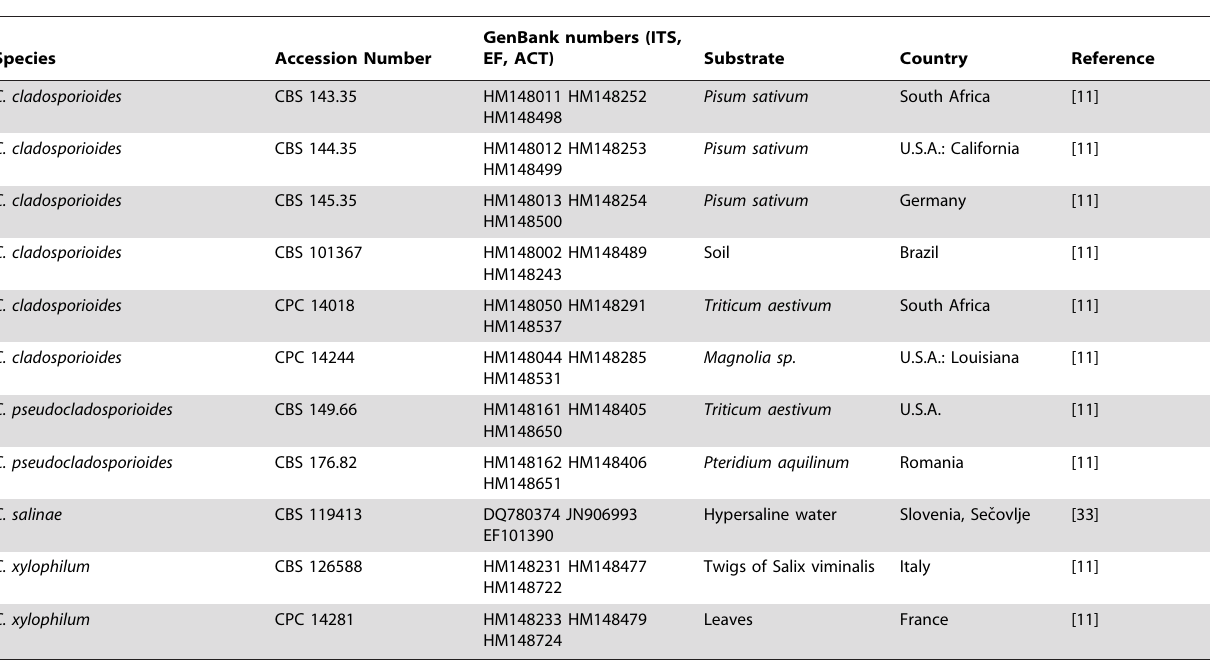
Table 1. Accession numbers of Cladosporium species used in the molecular characterization.